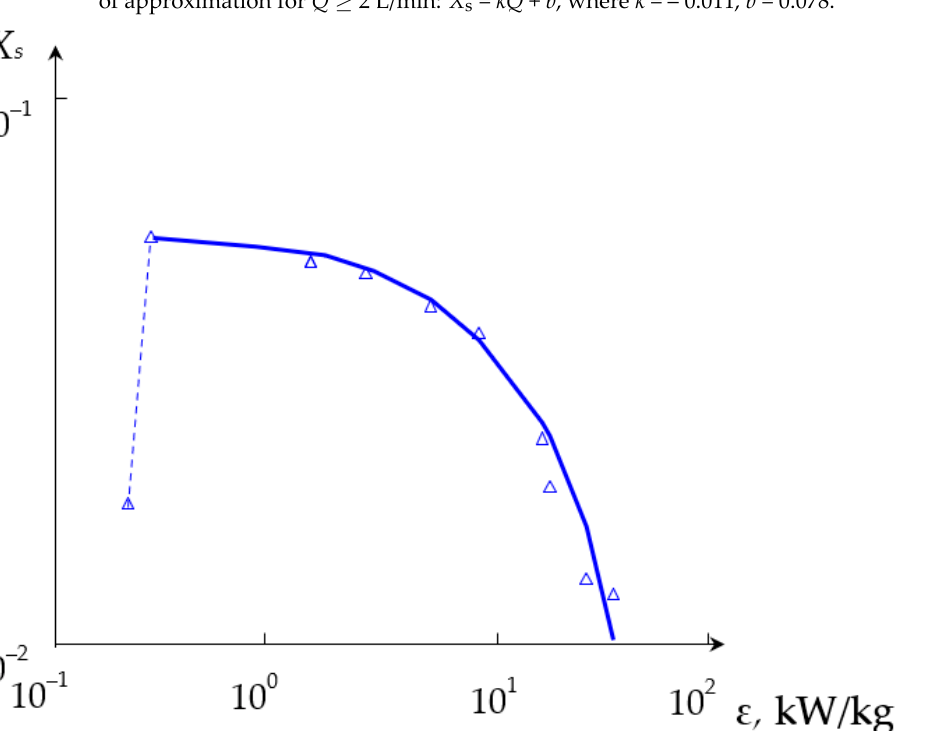
Figure 12. Dependence of the segregation index X s on the specific energy dissipation rate ε (kW/kg) for liquids supplied to two upper tangential branch pipes (TU1, TU2). Points—experimental data, line—result of smoothing.